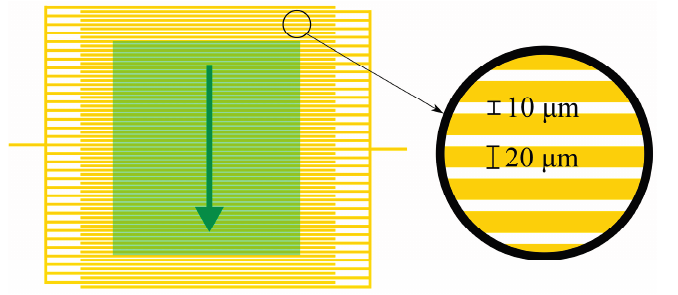
Figure 1. An example of gold IDE structure. The highlighted green region is the approximate region where a simulation would be valid. The green arrow denotes the cross sectional area that the 2D models in this paper